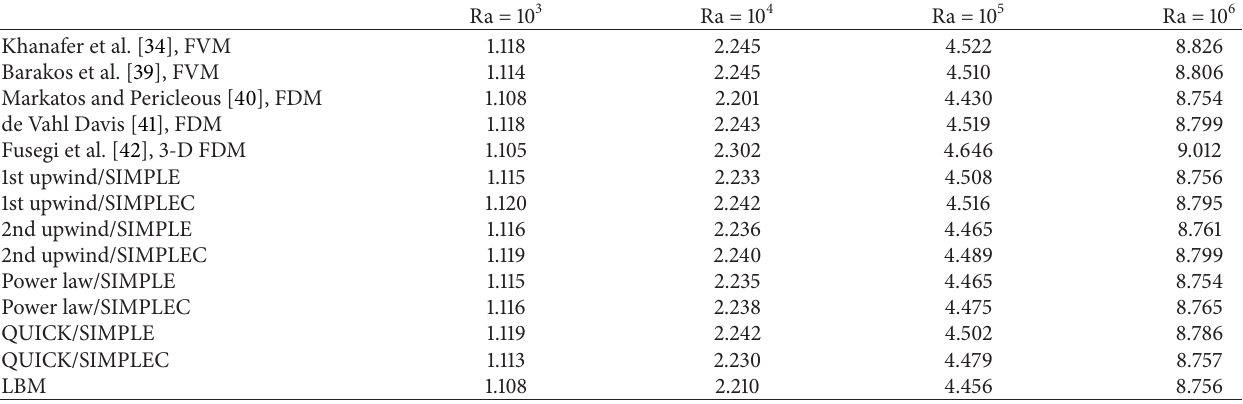
Table 4: Comparison of the average Nusselt number along the hot wall with those in the